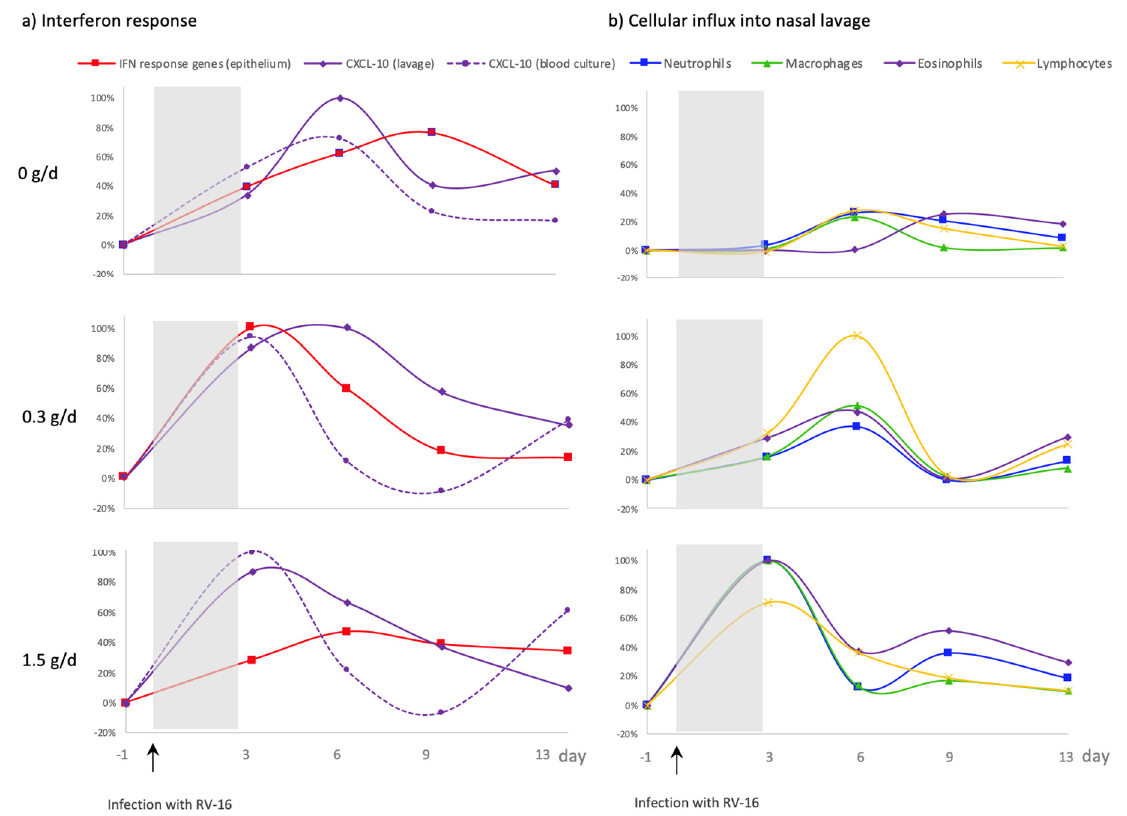
Figure 7. Kinetics of interferon responses and cellular influx after RV-16 infection ( ↑ ) expressed as change vs. d-1 calculated as percent of maximum effect across the three treatment groups. ( a ) Interferon responses in the local (nasal) compartment (CXCL-10 and IFN response genes), and in the systemic compartment (CXCL-10) after ex vivo stimulation. ( b ) Recruitment of immune cells into the local (nasal) compartment. Shaded area indicates time between infection and first biological marker sampling point.